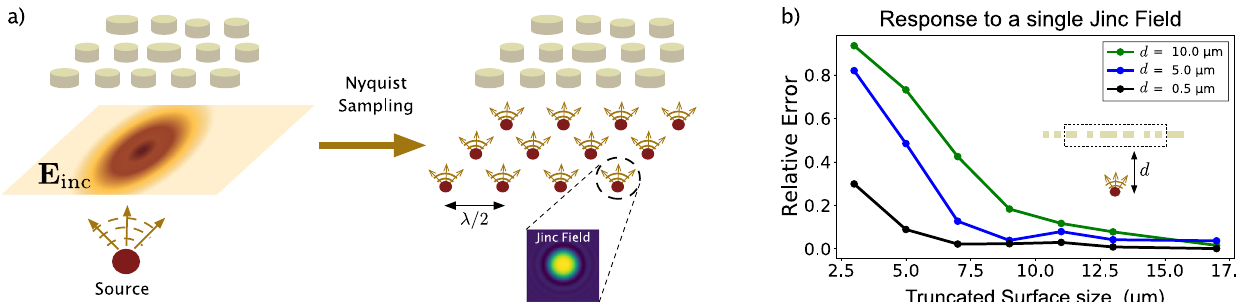
Fig. 1 Nyquist sampling of bandlimited incident fi eld. a Schematic of Nyquist sampling of the incident electric fi eld, which is bandlimited because it is propagating. b Percent error in scattered fi eld power versus spatial-extent of metasurface included in the simulation for a single jinc source placed 10 μ m (green), 5 μ m (blue), and 0.5 μ m (black) from the metasurface. The full metasurface is a 25 μ m × 25 μ m metasurface with focal length of 10 μ m, and the surface size on the x-axis of this convergence plot refers to the spatial-extent around the center of this metasurface that is included in the simulation. The y-axis relative error is computed assuming the simulation including the full metasurface is the converged result.